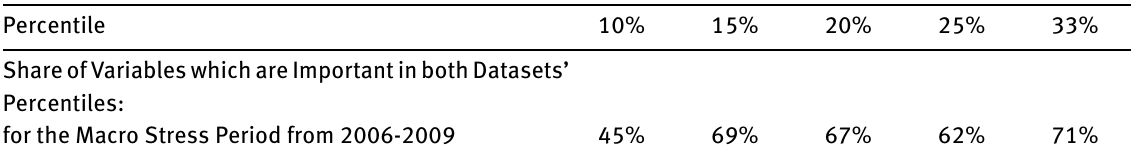
Table 6: Persistence of most important variables in stress/future estimation and empirical data, by percentile of the impor- tance distribution Percentile 10% 15% 20% 25% 33% Share of Variables which are Important in both Datasets’ Percentiles: for the Macro Stress Period from 2006-2009 45% 69% 67% 62% 71%